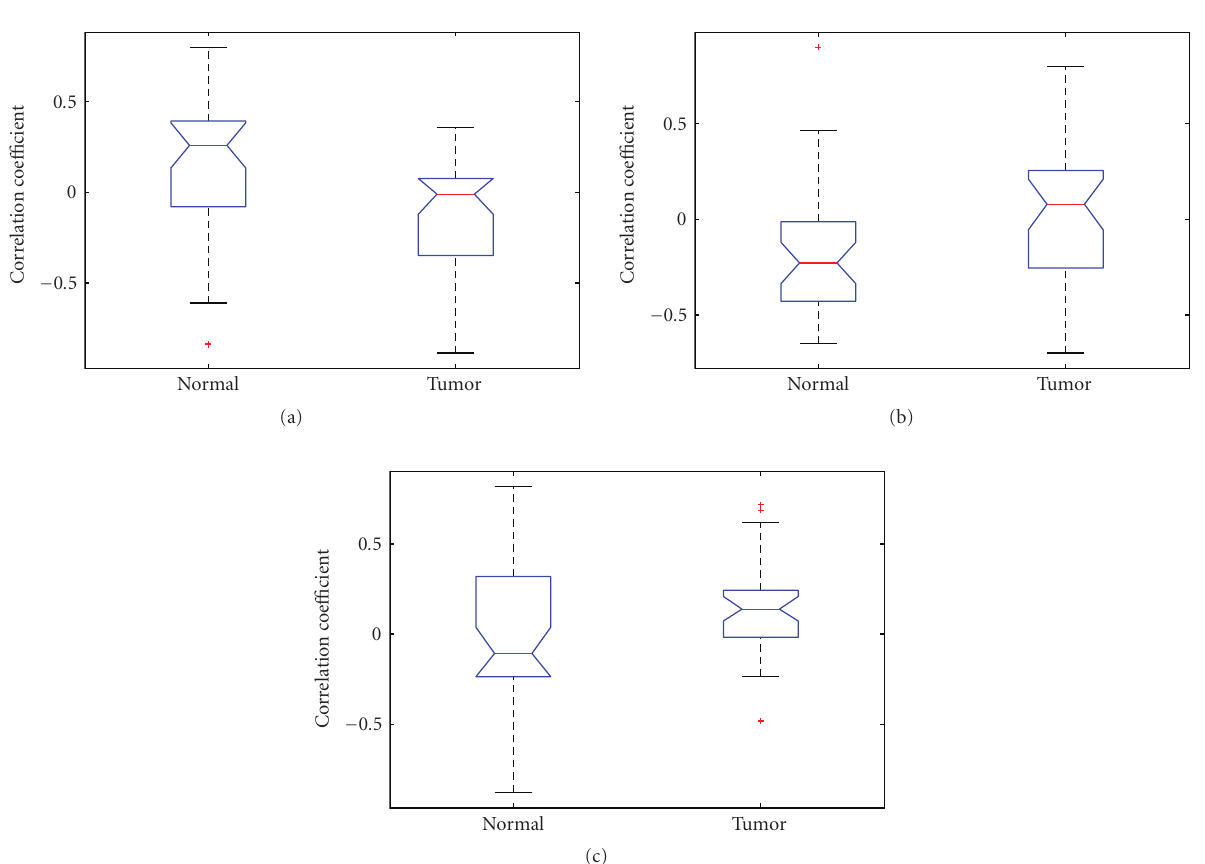
Figure 6: (a) Boxplot for RASSF2–KRAS. Pr( θ < 0 . 05) = 0 . 983. (b) Boxplot for MAZ–MYC. Pr( θ < 0 . 05) = 0 . 833. (c) Boxplot for PLSCR1– EGFR. Pr( θ < 0 . 05) = 0 .